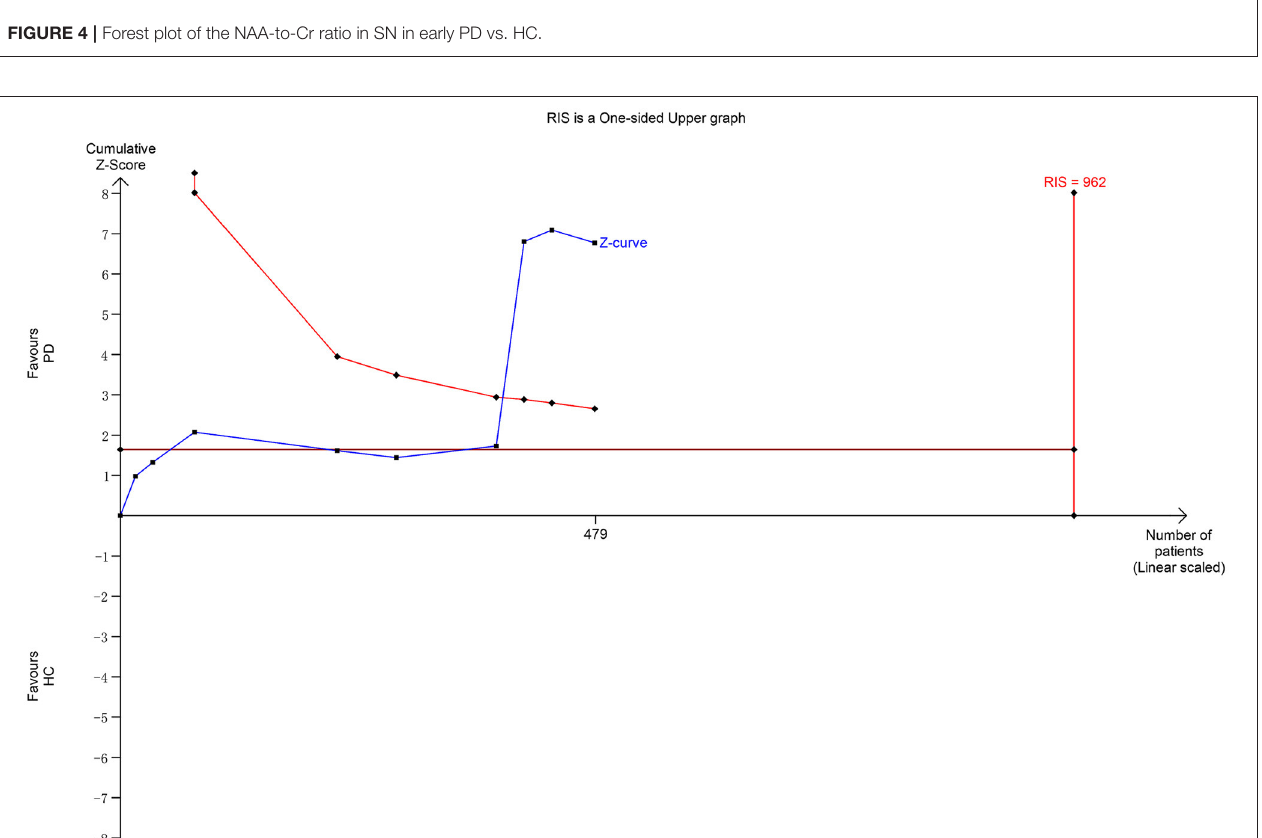
showed no significant differences in the NAA/Cr in the SN of patients with PD, a considerable decrease in the NAA/Cr was